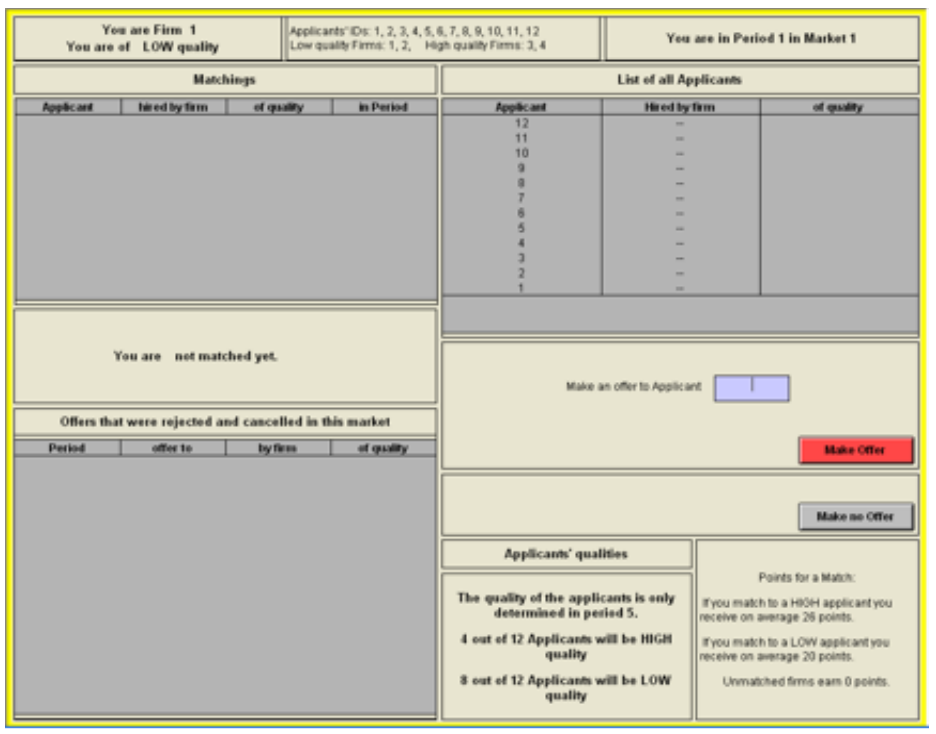
Figure 5. Firm Screen, Periods